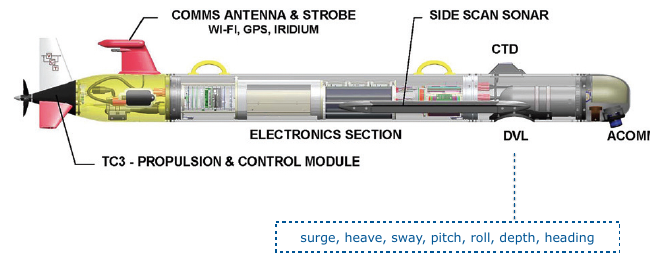
Figure 4. UUV Sensors (RPM, Waterspeed,